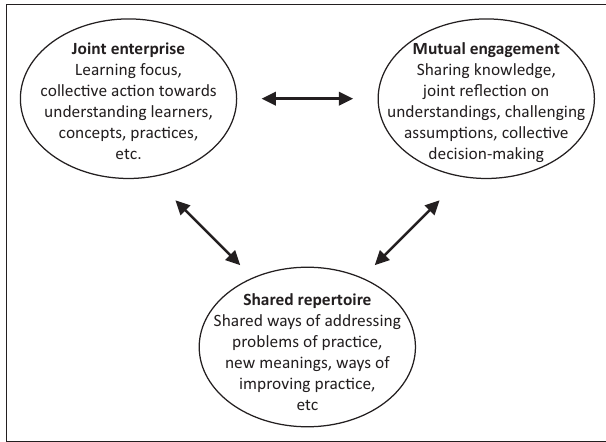
FIGURE 1: Dimensions of practice in a community of